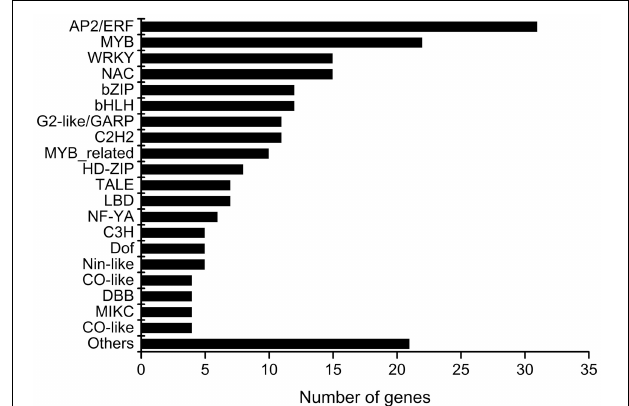
FIGURE 1 | Distribution of the 219 nitrate-responsive transcription factors according to family. Transcription factors were classify following PlantTFDB2.0 database annotation (Zhang et al.,